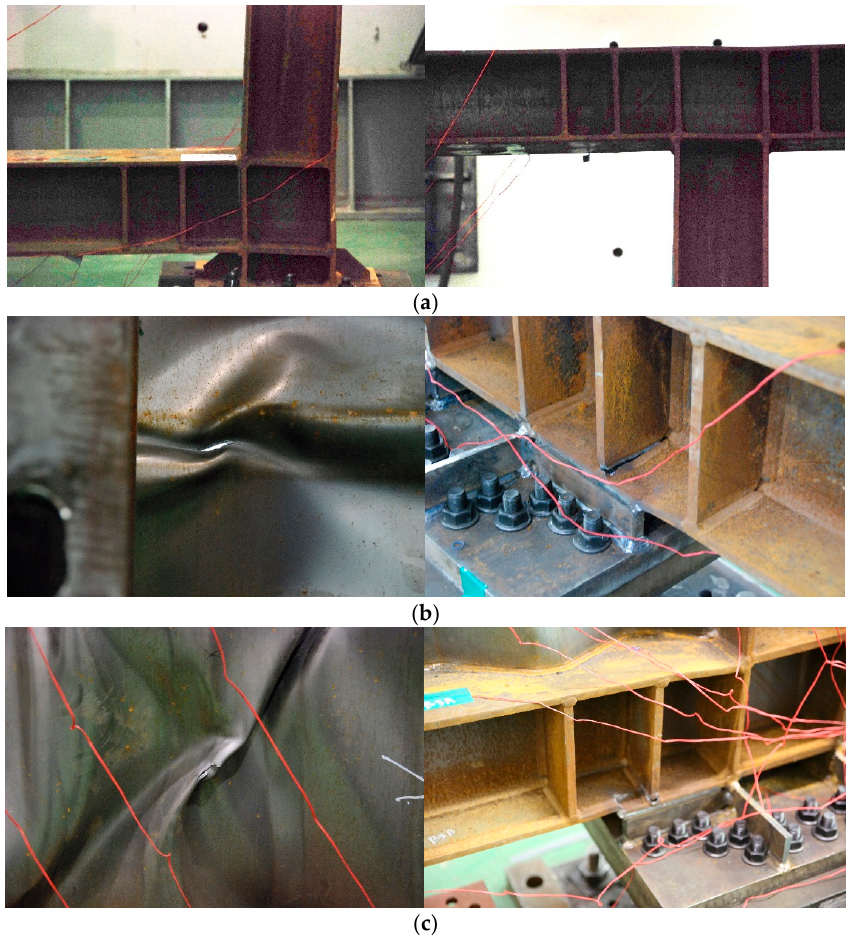
Figure 8. Observed failure location of the specimens: ( a ) FR-00; ( b ) FR-TR-V; ( c ) FR-TR-H.